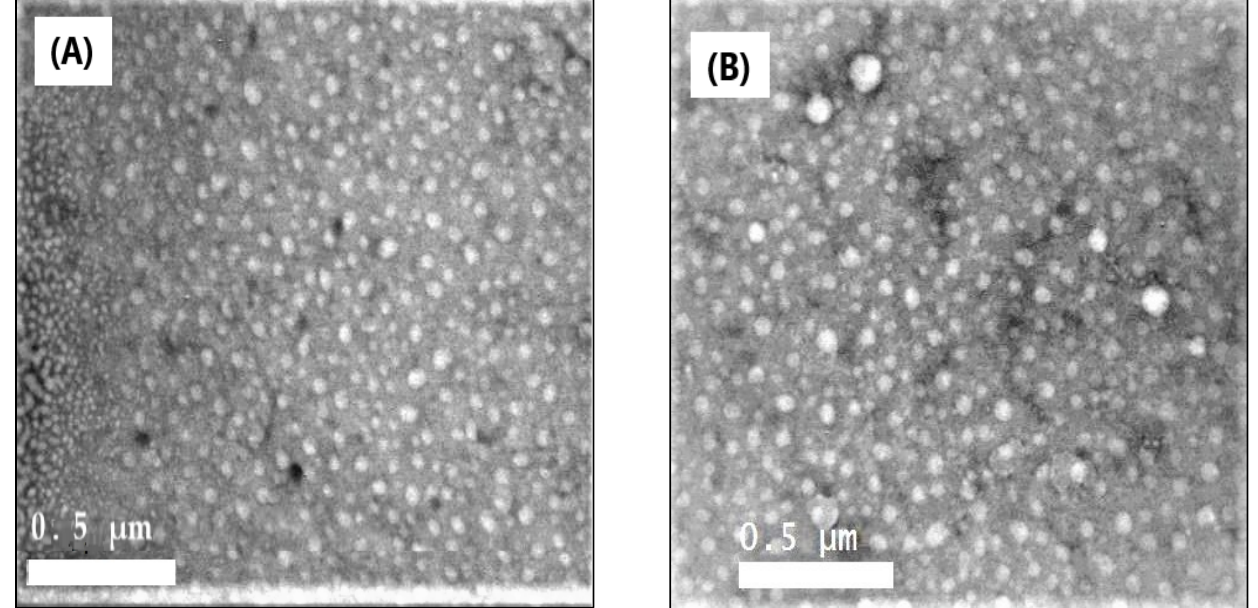
Figure 2. TEM images of ( A ) AmCs and ( B ) Q-AmCs2